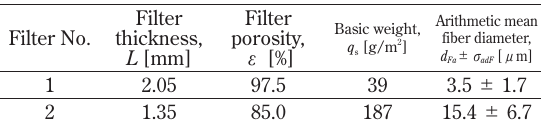
Table 1 Structural characteristic of the investigated filters Filter